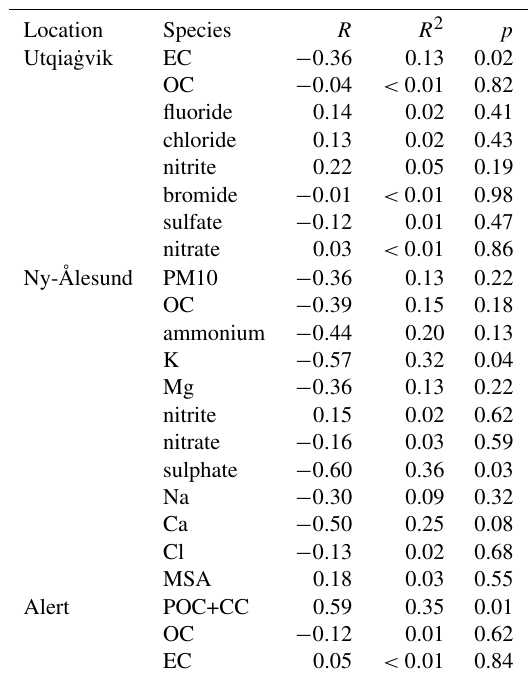
Table 1. R , R 2 , and p values for linear correlations between N INP (as shown in Fig. 2) and different bulk chemical